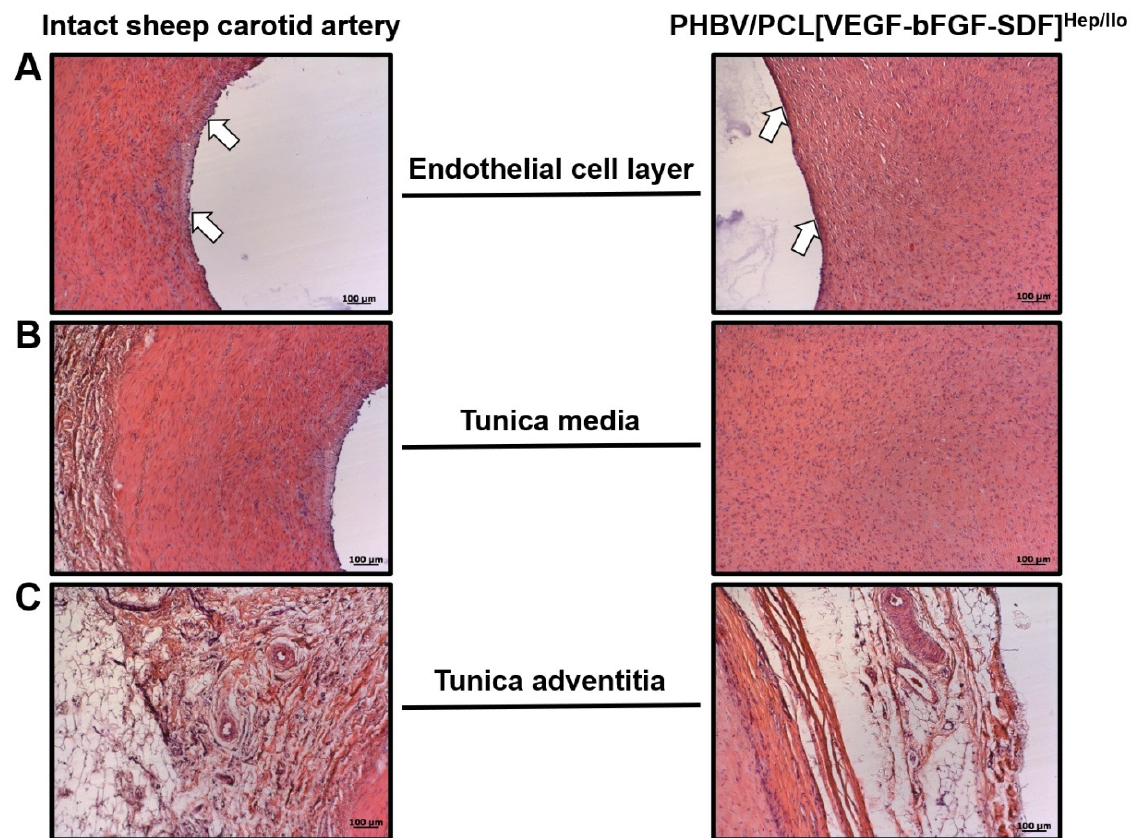
Figure 5. Histological comparison of the intact ovine carotid artery and regenerated artery which replaced PHBV/PCL[VEGF-bFGF-SDF] Hep/Ilo graft 18 months postimplantation. ( A ) Endothelial cell layer (indicated by white arrows); ( B ) Tunica media; ( C ) Tunica adventitia and perivascular adipose tissue. Haematoxylin and eosin staining, representative images, ×100 magnification.